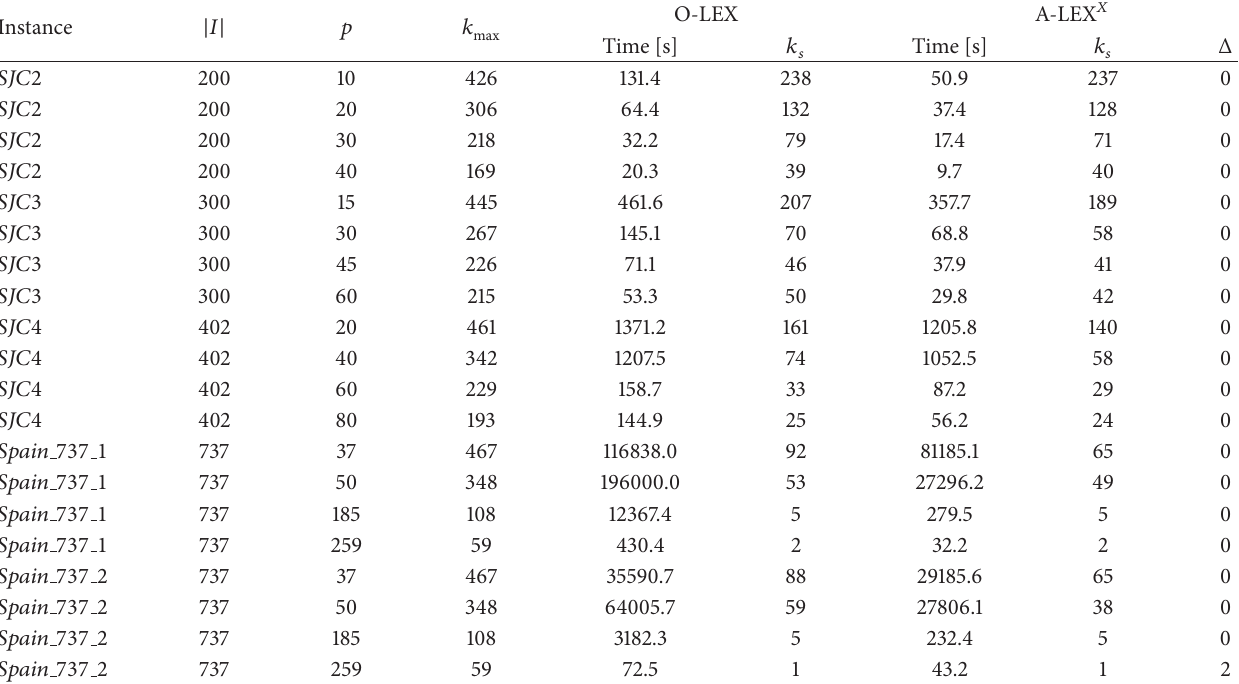
Table 2: Computational results for the algorithm A-LEX: medium